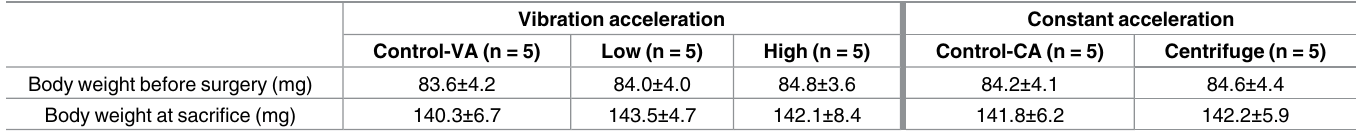
Table 2. Animal body weight in rib fracture healing model.